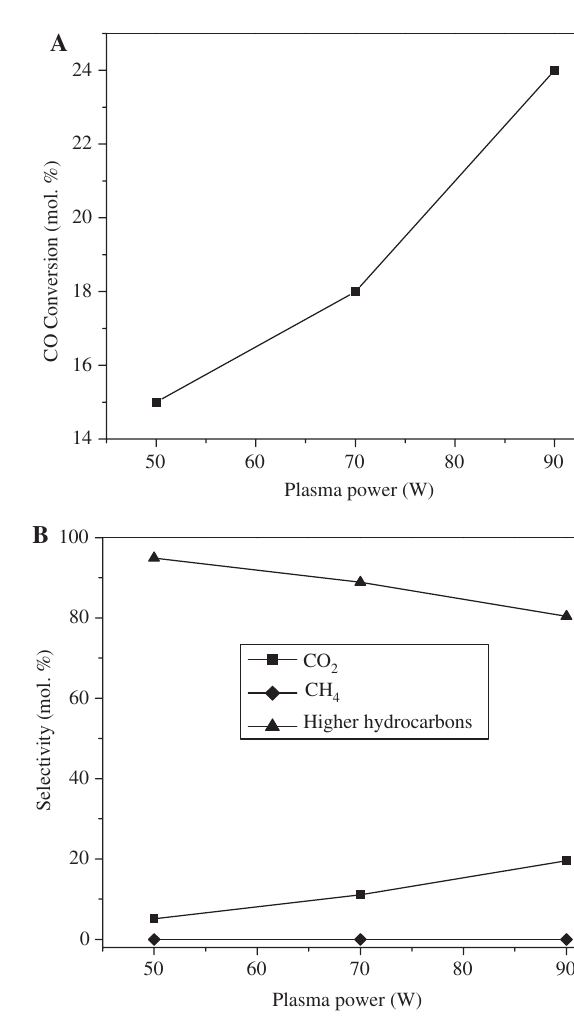
/CO molar ratio on FTS under conventional Figure 5 Influence of H 2 conditions. (A) Conversion; (B) selectivity. (Pressure: 6 bar; flow rate: 50 ml/min; wall temperature: 503 K.)